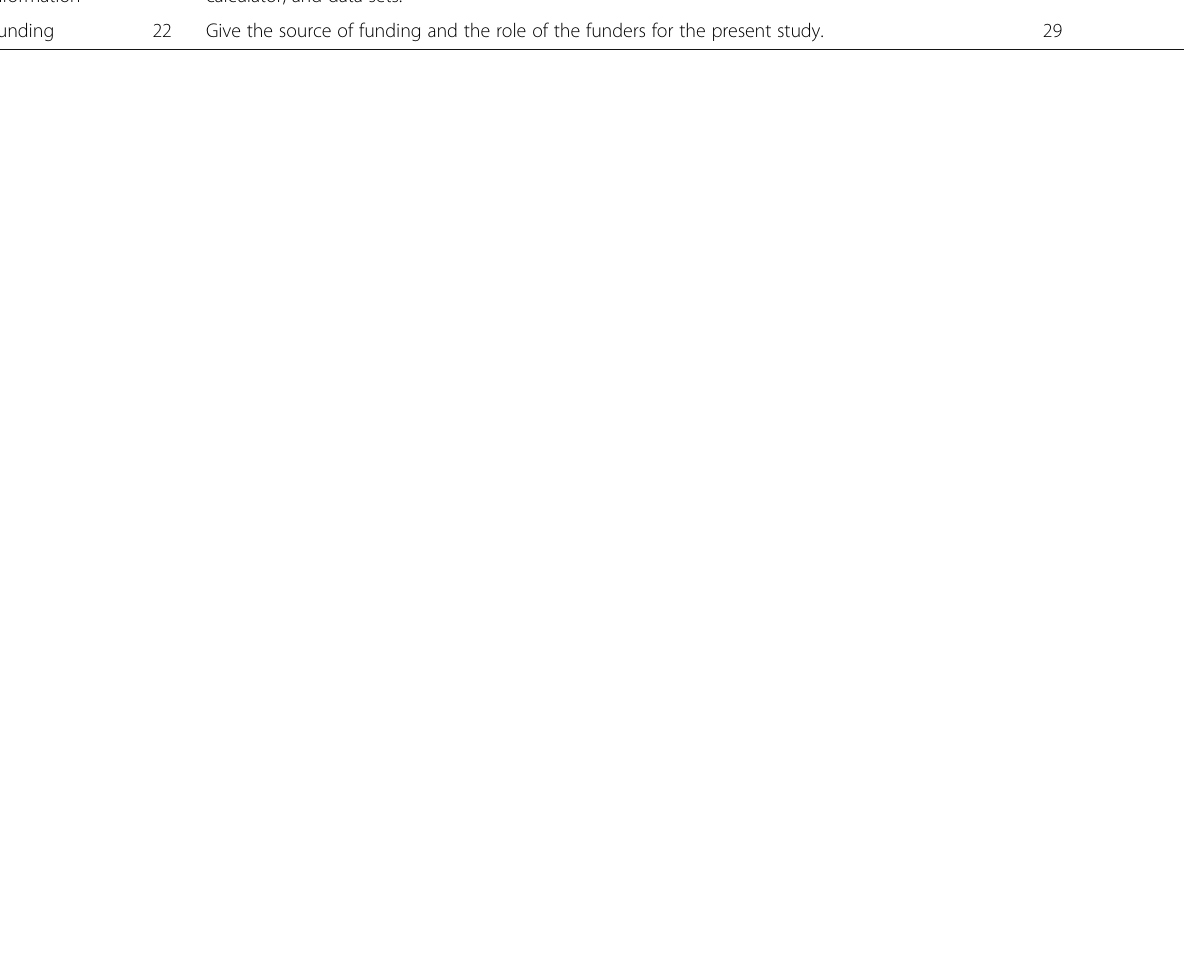
Table 4 Frequency of relapse within 2 years and frequency of treatment per cycle for patients that were included in one cycle only, patients that were included in two cycles and patients that were included in three cycles. Gender, age, and EDSS at the beginning of the 1st cycle separately for patients with one cycle only, with two cycles, and with three cycles. Individuals with one cycle are mainly patients that were recent to the study, whereas individuals with three cycles are those recruited in the study, when